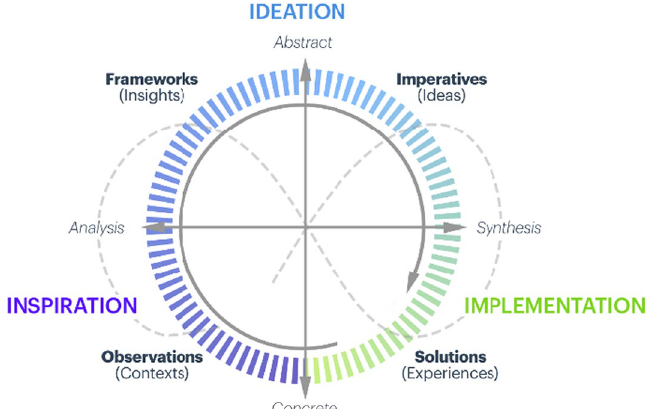
Fig. 3 Hybrid model of design thinking, which is a design process workaround with design thinking and innovation adapted from the work of Beckman and Barry (2007), Brown (2008, 2009), Brown and Wyatt (2010), Brown and Katz